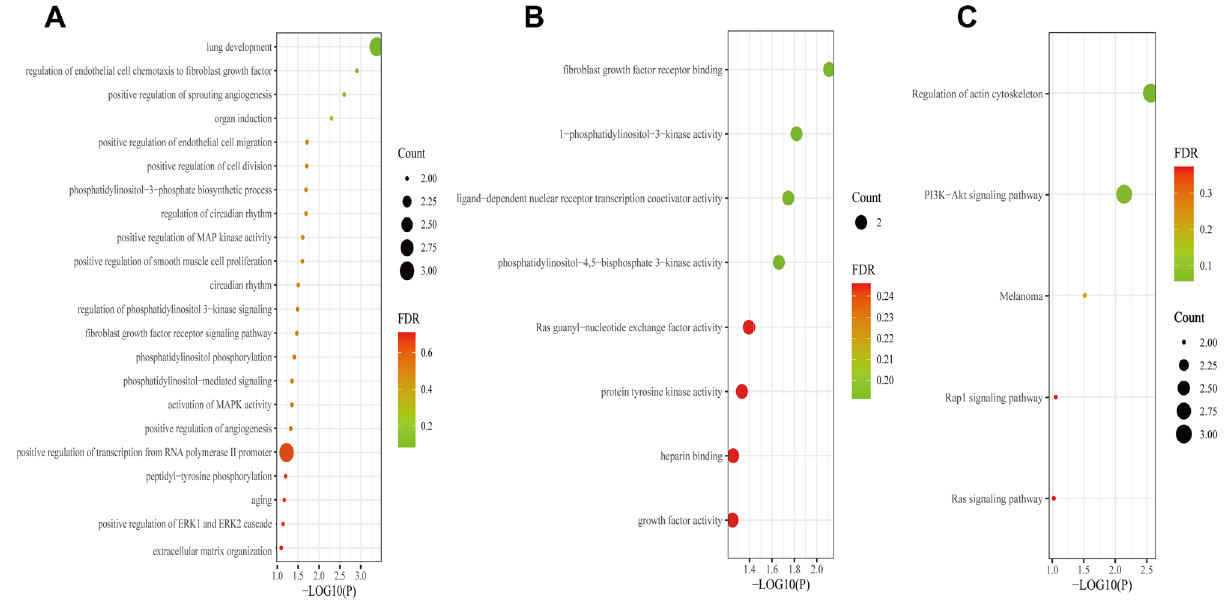
Figure 3. Functional characterization of the common DEGs. ( A ) Results from biological process related GO term identification derived from P-adjust and combined gene counts. ( B ) Results from molecular function related GO term identification. ( C ) Pathway analysis result identification through KEGG. X-axis represents the P -value (-log10 P) and Y-axis represents the term of gene function. The color of the bubble represents the FDR value, and the bubble size indicates the number of genes enriched in the same function.